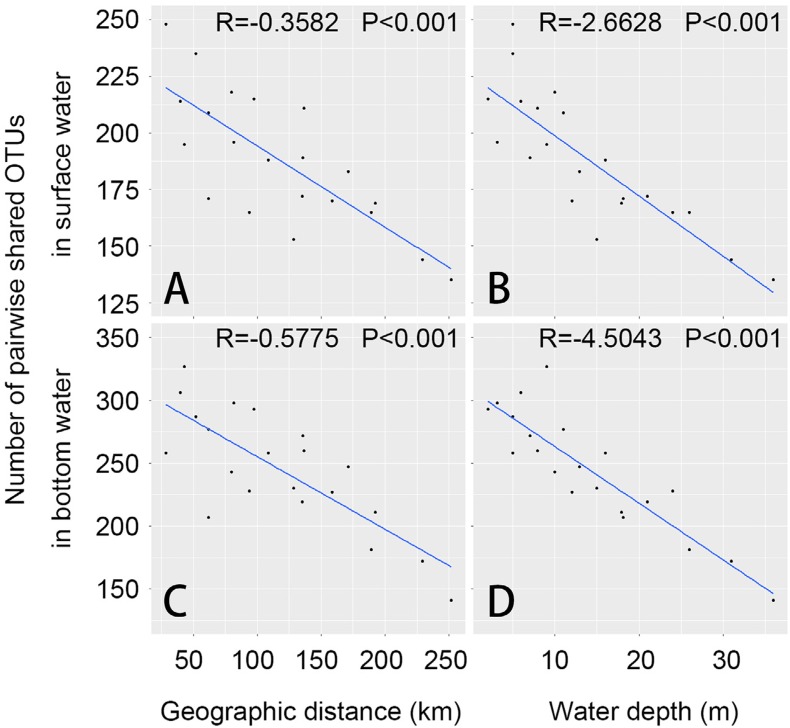
Relationships between geographic distance, water depth and numbers of pairwise shared OTUs are shown in this figure.Scatter plots were generated separately for samples from surface (A–B) and bottom water (C–D). Regression lines, along with regression coefficients (R) and probability (P), were generated using general linear model (GLM).